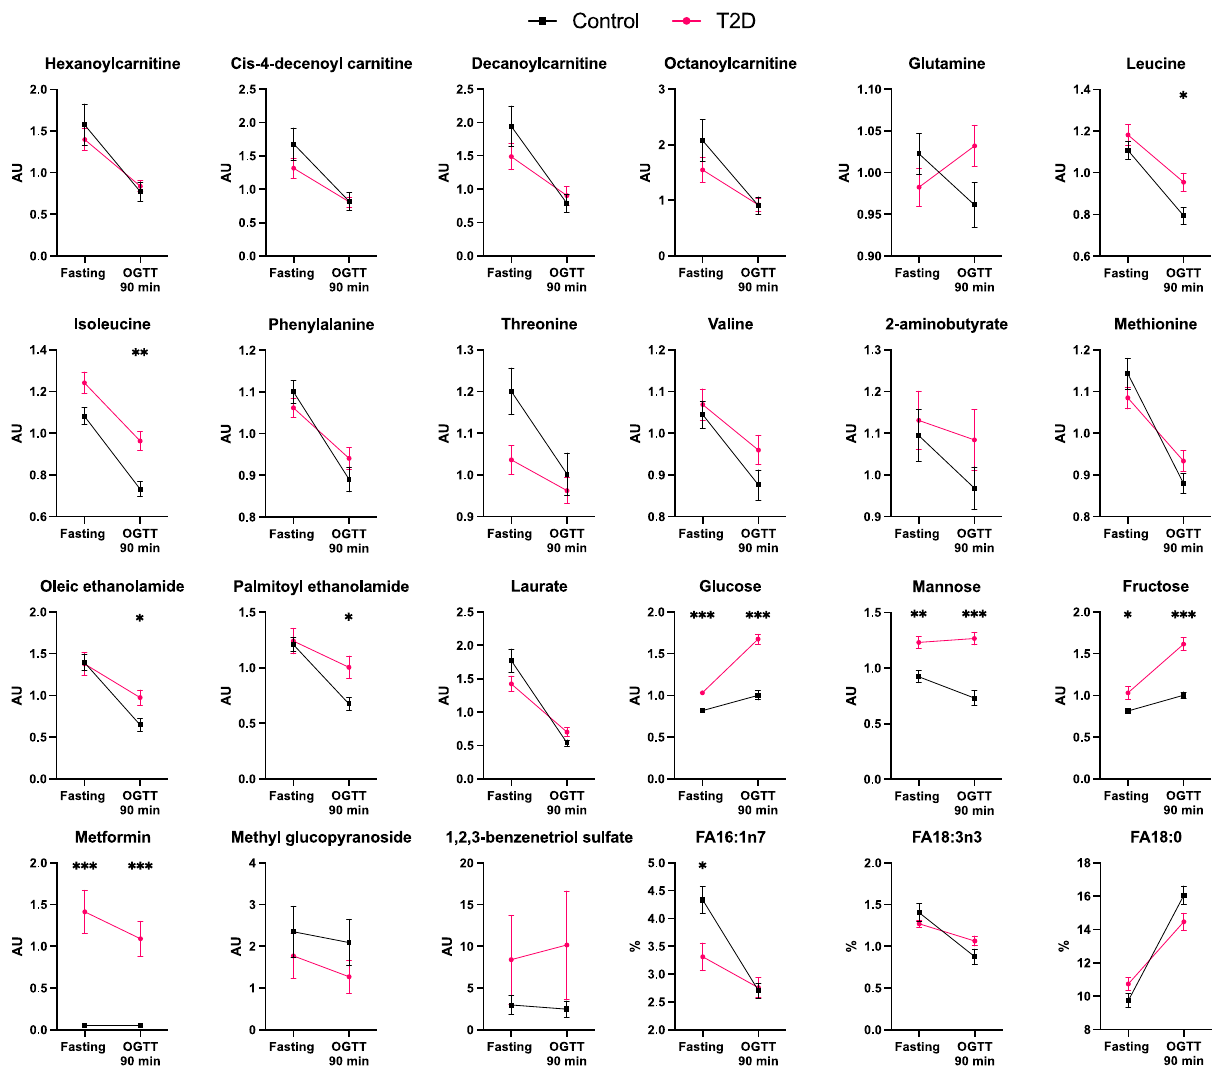
Figure 2. Fasting and 90 min post-OGTT plasma levels of the metabolites that significantly differ in response to the OGTT between control and T2D subjects ( n = 20 per each group). FA16:1n7: palmitoleic acid. FA18:0: stearic acid. FA18:3n3: alpha-linoleic acid. Data are presented as mean ± SEM. AU, arbitrary units. %, percentage of the free fatty acid family total concentration. * p < 0.05, ** p < 0.01, *** p < 0.001 for differences between controls and T2D individuals (Mann – Whitney tests).